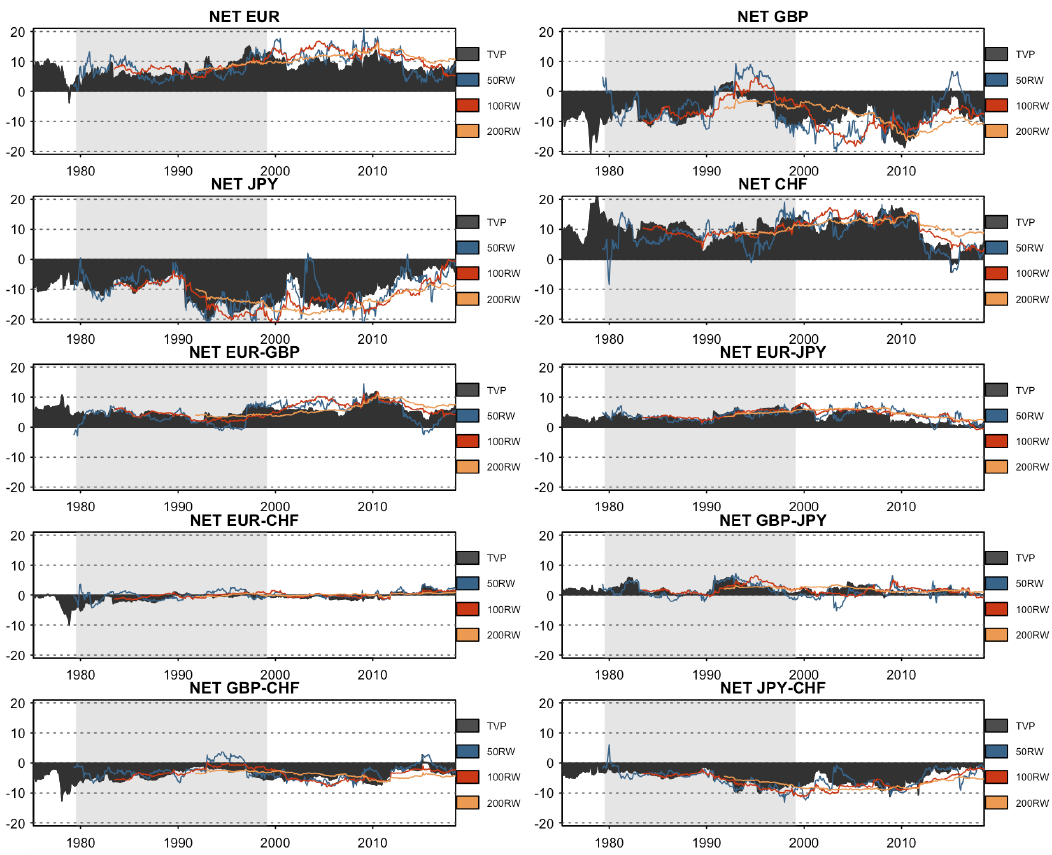
Figure 8. Net total and net pairwise directional connectedness